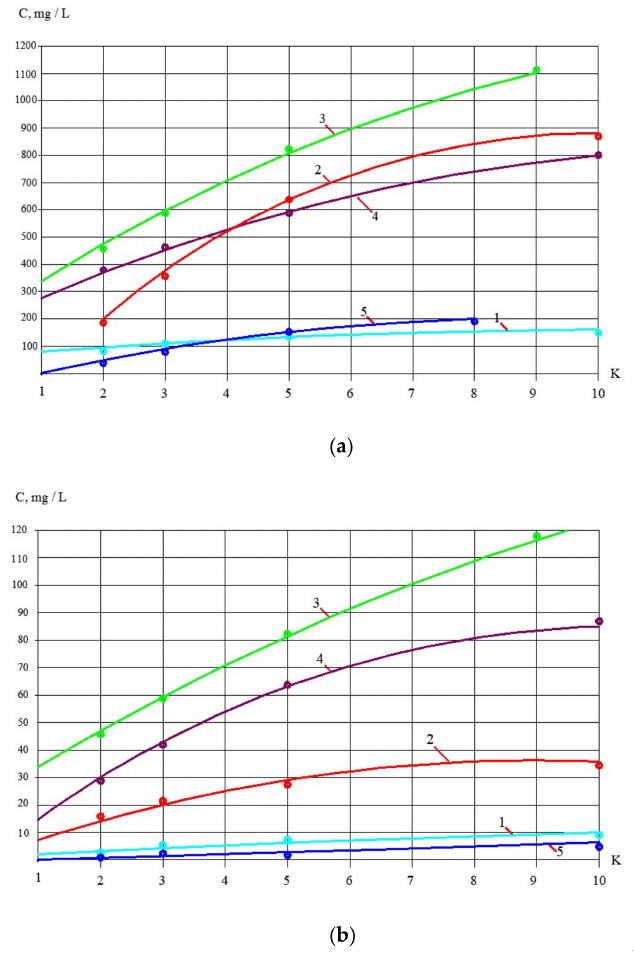
Figure 8. Results of treatment of the reject effluent after sludge dewatering with nanofiltration membrane (step 3, the first series of experiments). Dependencies of different impurity concentrations on K values: ( a ) – in product water; ( b ) – in concentrate. 1—chlorides; 2—sulphates; 3—calcium; 4—COD; 5—aluminum.